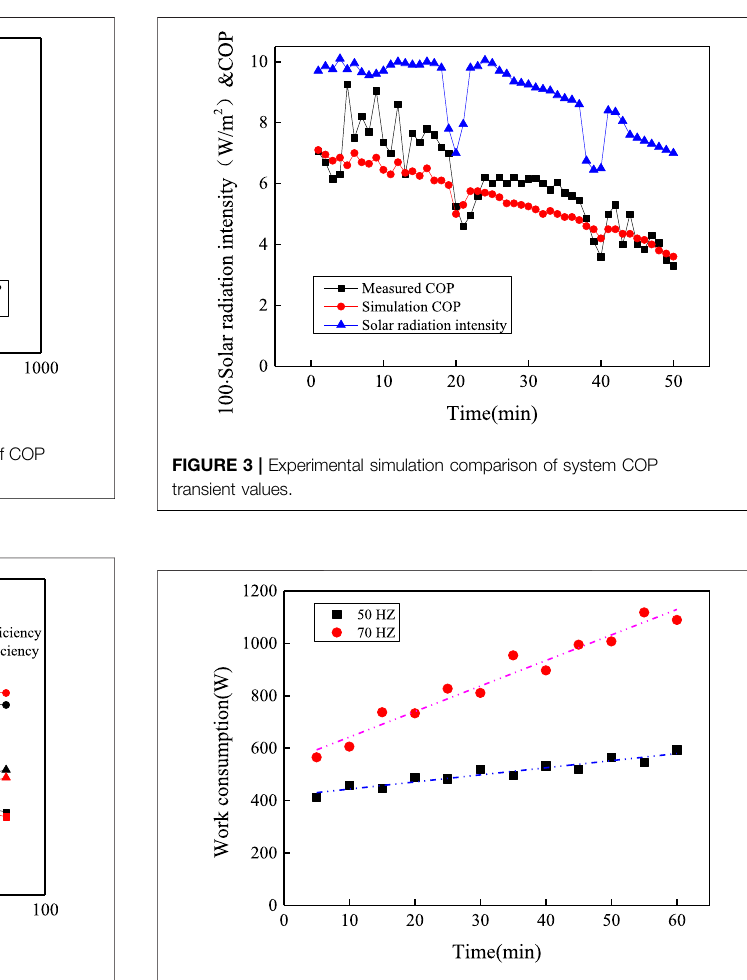
FIGURE 4 | Compressor power consumption